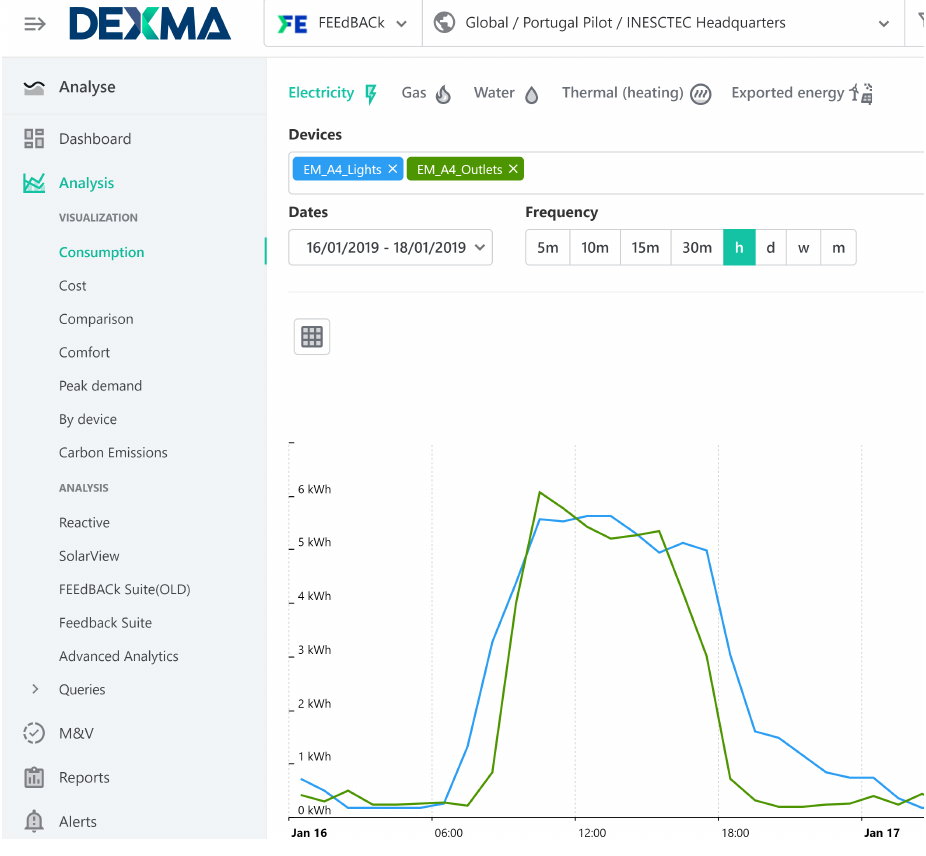
Figure 4. Chart with energy metering obtained from the DEXCell platform (Dexma partner); see Section